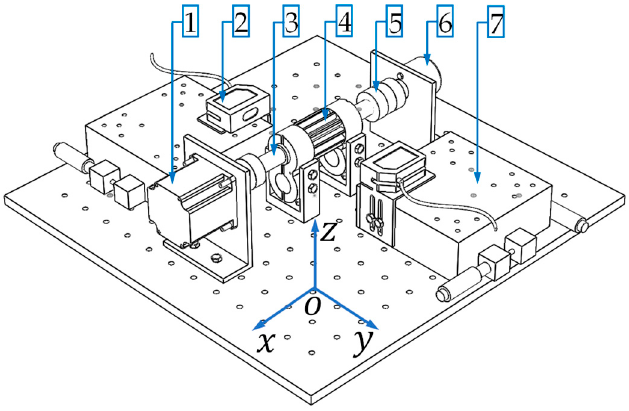
Figure 1. The proposed apparatus to measure the gear tooth profiles: 1 : Stepper motor; 2 : laser triangulation sensor (LTS); 3 : gear shaft; 4 : target gear and a pair of supporting journal bearings; 5 : flexible shaft coupler; 6 : rotary encoder; and 7 : micro motion stage.